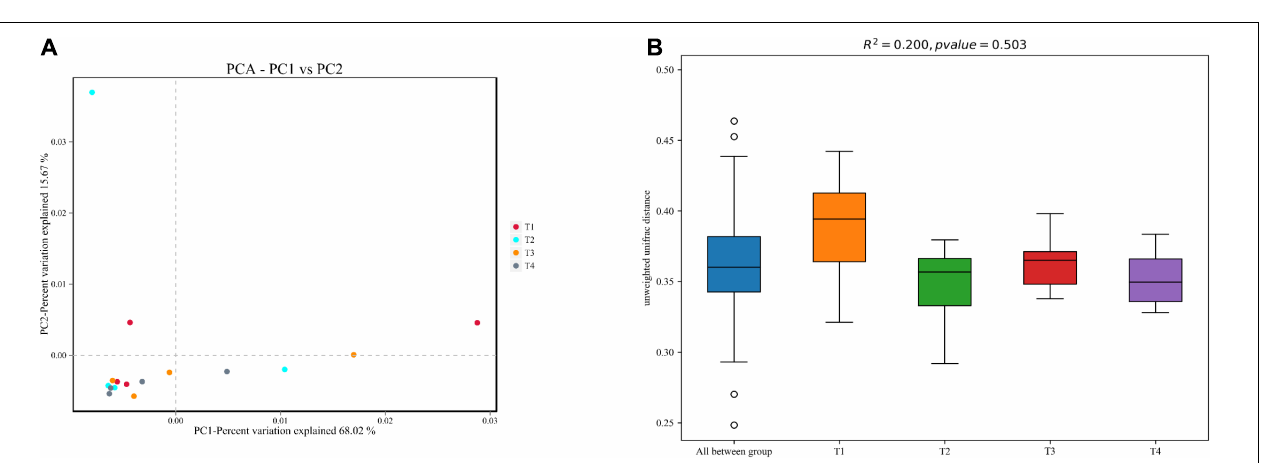
FIGURE 3 | Venn diagram depicts unique and shared OTUs of gut microbiota in E. coioides at day 56.